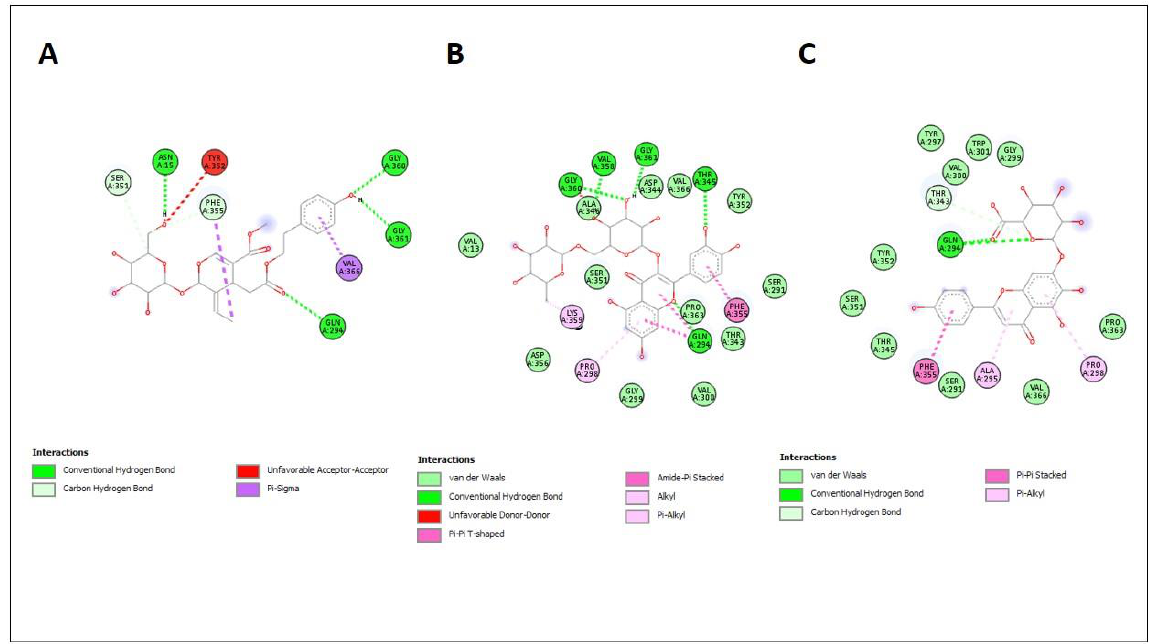
Figure 7. Enzyme tyrosinase and ligands interaction. Lingstroside ( A ), Rutin ( B ), Scutellarin ( C ).